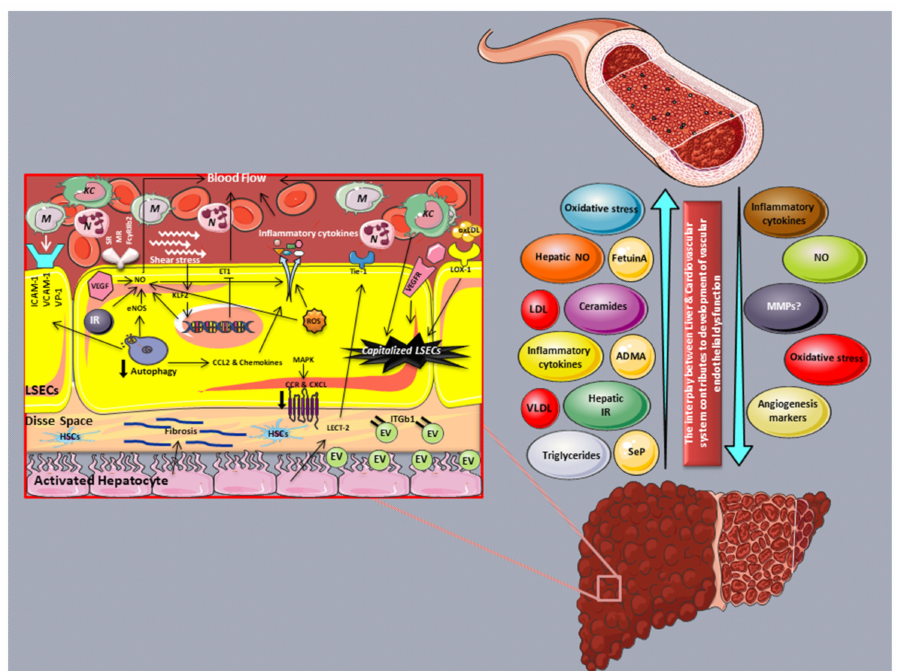
Figure 1. The role of endothelial cells in NAFLD pathogenesis and the interplay between CVD and NAFLD. LSECs are located at the interface between the blood stream and the liver parenchyma. LSECs regulate blood flow in response to shear stress, mainly through increased NO synthesis and bioavailability as well as through ET-1 reduction, which are both mediated by KLF2. LSECs also regulate the activation of KCs and HSCs during NASH progression. The expression of SRs, MR, and Fc γ RIIb2 endows LSECs with high endocytic capacity; of note, the reduced endocytic capacity of LSECs precedes fibrosis in NAFLD. The increased expression of adhesion molecules during the early stage of NAFLD enhances the recruitment of monocytes to the inflamed endothelium, leading to the activation of an inflammatory response in NASH. Impaired autophagy has been associated with the development of steatosis and fibrosis through—among others—the upregulation of adhe- sion molecules and pro-inflammatory mediators during the progression of the disease.